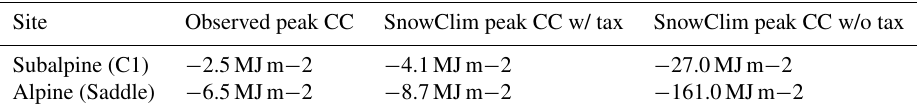
Table A1. Comparison of peak seasonal cold content values from observations, SnowClim simulations including the tax approach described in Sect. 2.2.6, and SnowClim simulations without the tax approach at two sites from the Niwot Ridge Long-Term Ecological Research site in